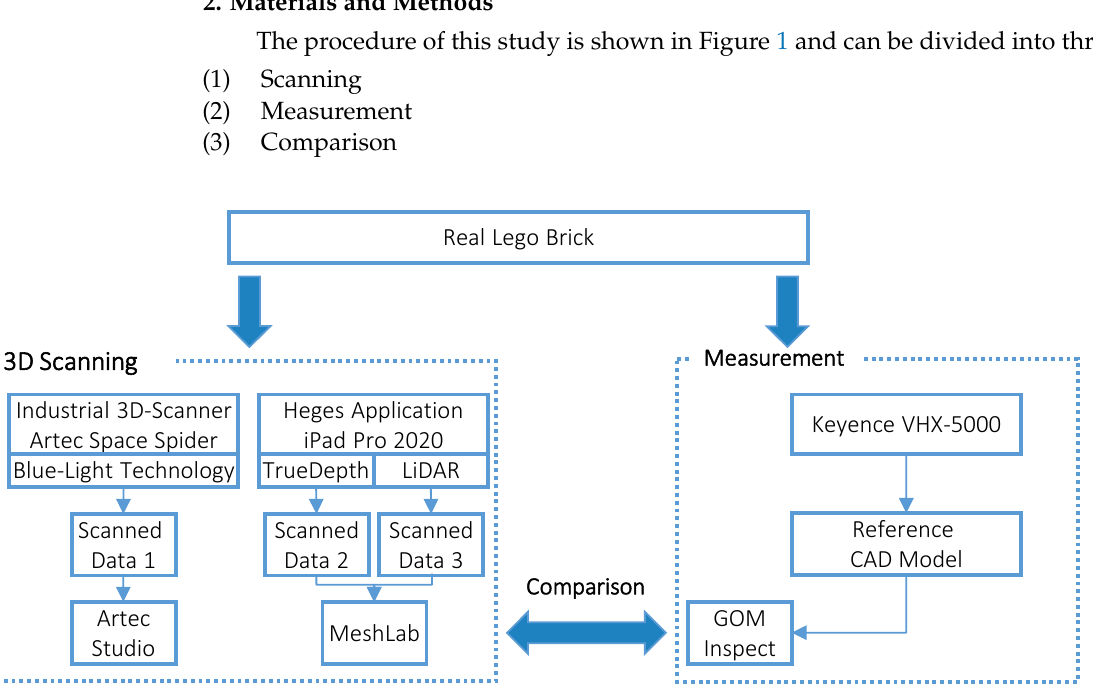
Figure 1. Schematic illustration of the procedure to evaluate the accuracy of TrueDepth and light detection and ranging (LiDAR) using an iPad Pro (2020) in comparison to an industrial 3D scanning system.